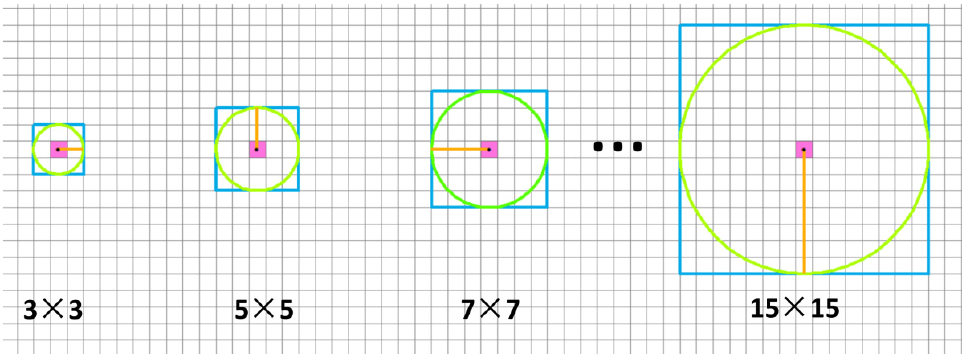
Figure 6. Various window sizes from 3 × 3 to 15 × 15 used in treetop